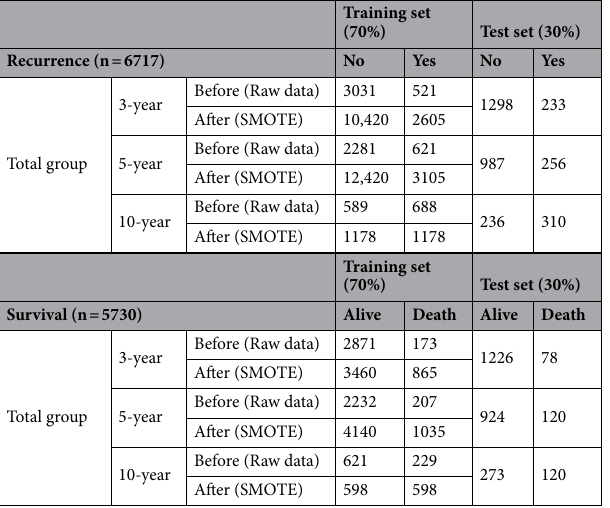
Table 1. Distribution of data sets before and after synthetic minority oversampling technique application